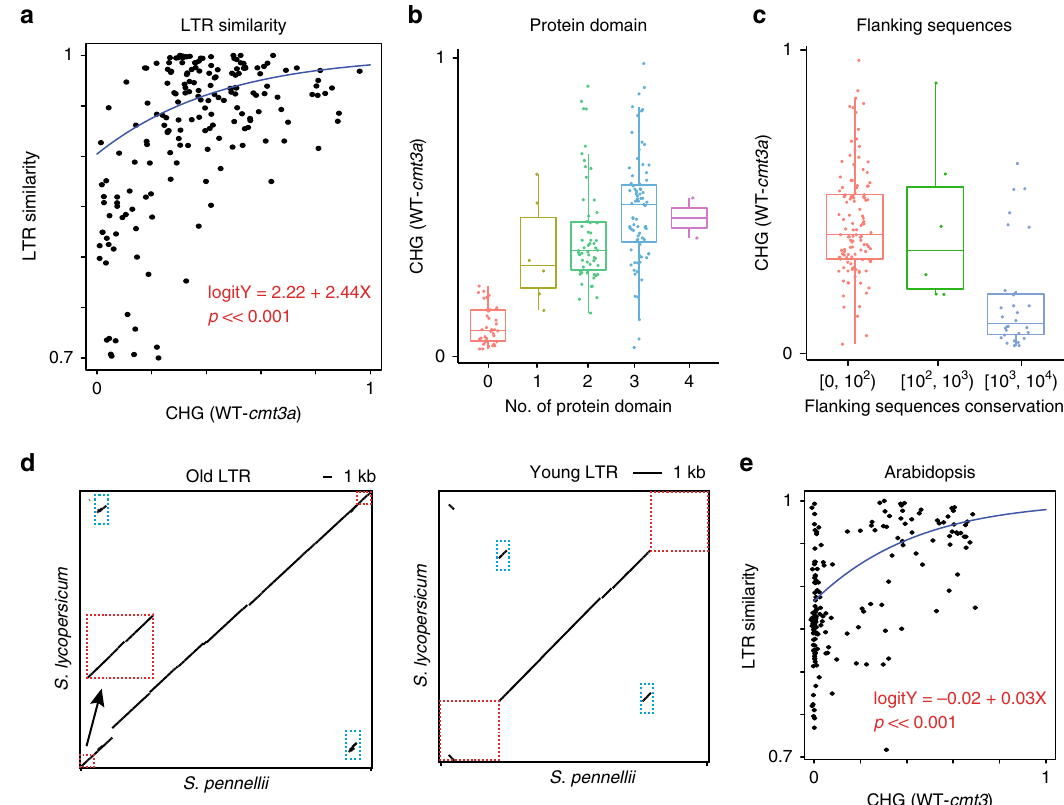
Fig. 4 CMT3a-targeted intact LTRs are evolutionarily younger elements. a Scatter plot of distal intact LTRs. X -axis represents the reduction of CHG methylation in cmt3a , y -axis represents the 5 ′ and 3 ′ LTR similarity. Regression-blue line. The regression model and p value are indicated in red. The p value is relative to the null hypothesis of there being a gradient of zero and so no causal relationship between the reduction of CHG methylation in cmt3a and the 5 ′ and 3 ′ LTR similarity. b Correlation of number of predicted protein domains of each intact LTRs ( x -axis) and reduction of CHG methylation in cmt3a ( y -axis). c Alignments results of intact LTR fl anking sequences (2 kb upstream and 2 kb downstream) between S. lycopersicum and S. pennellii . X -axis represents three ranges of the alignment score by BLASTn. Y -axis represents the reduction of CHG methylation in cmt3a. d Dot plots of each one example of old and young element comparing the LTR sequence from S. lycopersicum and its homologous sequence in S. pennellii genome, plus 2 kb upstream and downstream regions. Blue boxes highlight the 5 ′ and 3 ′ LTRs. Red boxes highlight the fl anking regions. e Scatter plot of Arabidopsis distal intact LTRs. X -axis represents the reduction of CHG methylation in cmt3 , y -axis represents the 5 ′ and 3 ′ LTR similarity. Regression-blue line. The regression model and p value are indicated in red. The p value is relative to the null hypothesis of there being a gradient of zero and so no causal relationship between the reduction of CHG methylation in cmt3 and the 5 ′ and 3 ′ LTR